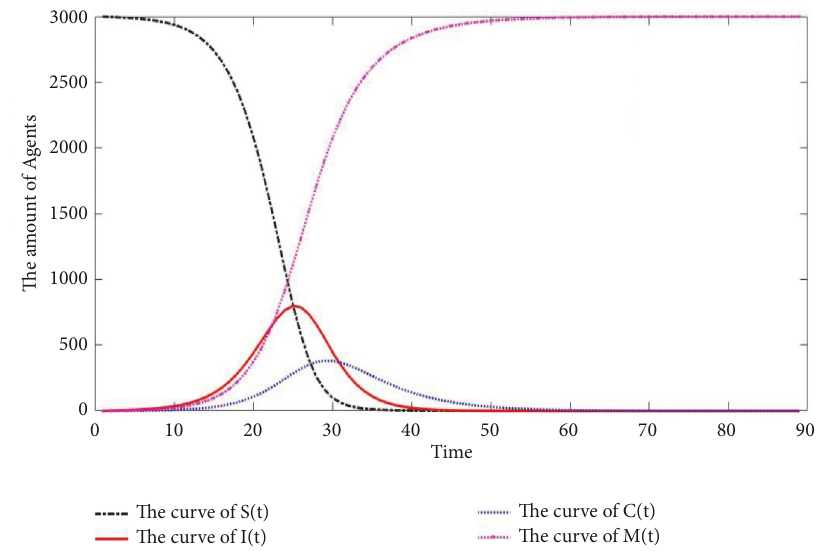
Figure 3: The evolutionary characteristics of risk contagion after increasing 𝑥 1 (Case